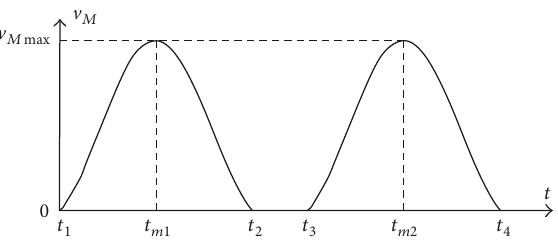
Figure 2: Change curve of velocity with time for the slider.